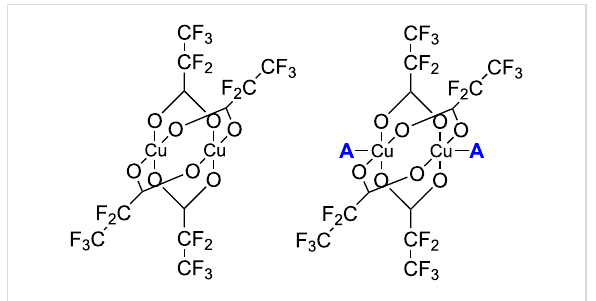
Figure 1: A schematic structure of investigated molecules (left) [Cu 2 (µ- O 2 CC 2 F 5 ) 4 ], (right) [Cu 2 (EtNH 2 ) 2 (µ-O 2 CC 2 F 5 ) 4 ], [Cu 2 ( t -BuNH 2 ) 2 (µ- O 2 CC 2 F 5 ) 4 ], and Cu 2 ( s -BuNH 2 ) 2 (µ-O 2 CC 2 F 5 ) 4 ], where A represent dif- ferent amine